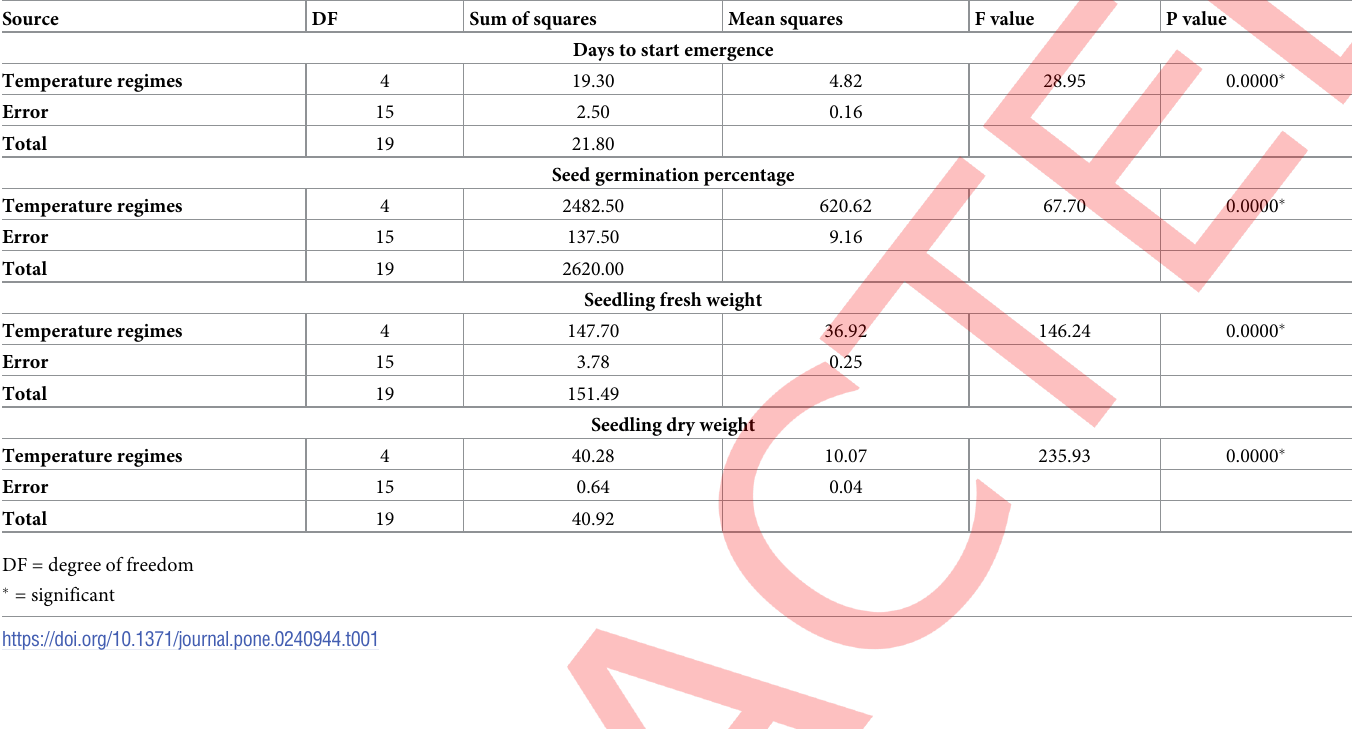
Table 1. Analysis of variance for days to start emergence, seed germination percentage and seedling fresh and dry biomass of wild oat under different constant tem- perature